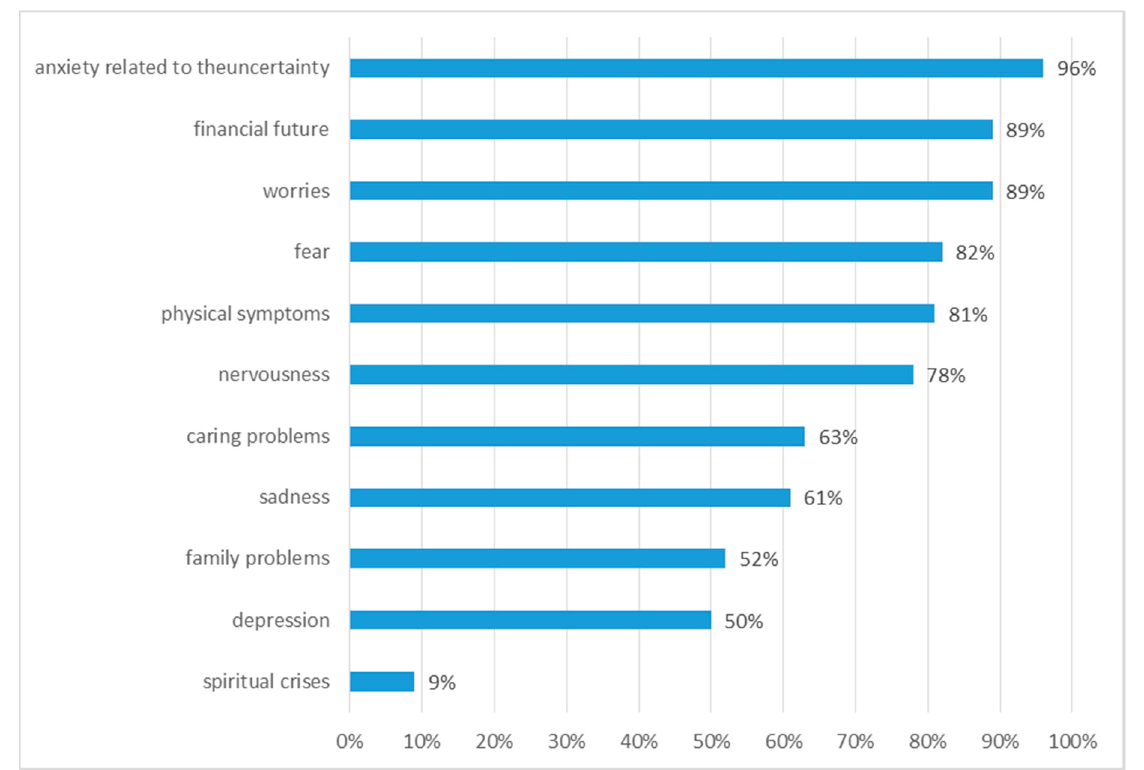
Figure 5. Categories of emotional stress reported by